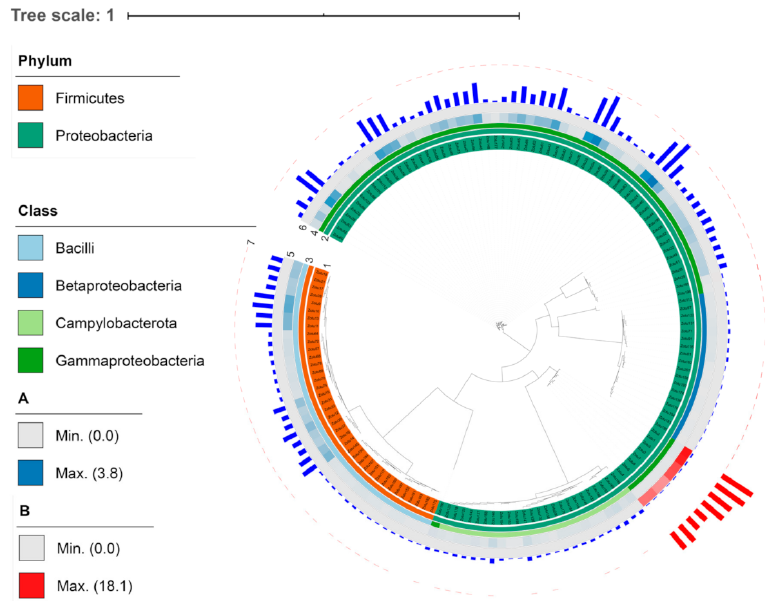
Figure 3. Phylogenetic relationship and annotation of ZOTUs (zero-radius operational taxonomic units) obtained in the gill of bathymodiolin mussel G. haimaensis and vesicomyid clam A. marissinica . From inner to outer: ring 1 represents all the ZOTUs detected this study; rings 2 and 3 indicate the phylogenetic classification of ZOTUss at the phylum and class level, respectively, and their legends were in the left part; rings 4 and 5 with heatmaps show the relative abundance of ZOTUs in abundance in each group. The legends were in the left part with G. haimaensis (Group A) and A. marissinica (Group B). The outer rings 6 and 7 with histograms demonstrated a relative abundance of ZOTUs in G. haimaensis (blue) and A. marissinica (in